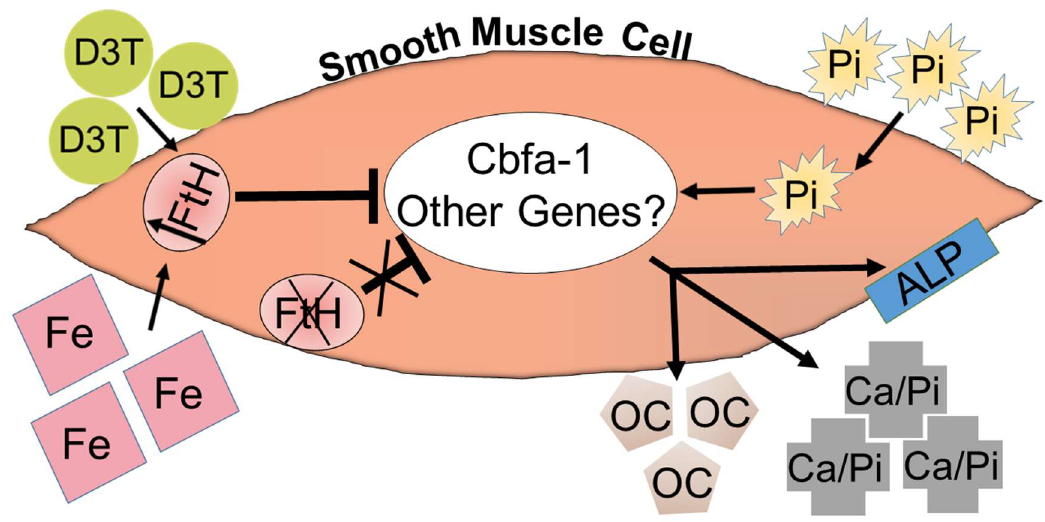
Figure 1. Overall schematic of the proposed mechanism of the inhibition of VSMC calcification via the upregulation of FtH. The figure depicts a vascular smooth muscle cell (VSMC) where elevated levels of Pi (phosphorus) induce the upregulation of cbfa-1 (core binding factor alpha-1), leading to the deposition of extracellular Ca / Pi (hydroxyapatite crystals) and the activation of osteoblastic genes, including OC (osteocalcin) and ALP (alkaline phosphatase). This process can be exacerbated by the deletion of FtH (ferritin heavy chain) or mitigated via D3T (3H-1,2-Dithiole-3-thione) and Fe (iron)-induced FtH upregulation. There may still be novel genes and pathways modulated by FtH expression that require further investigations.